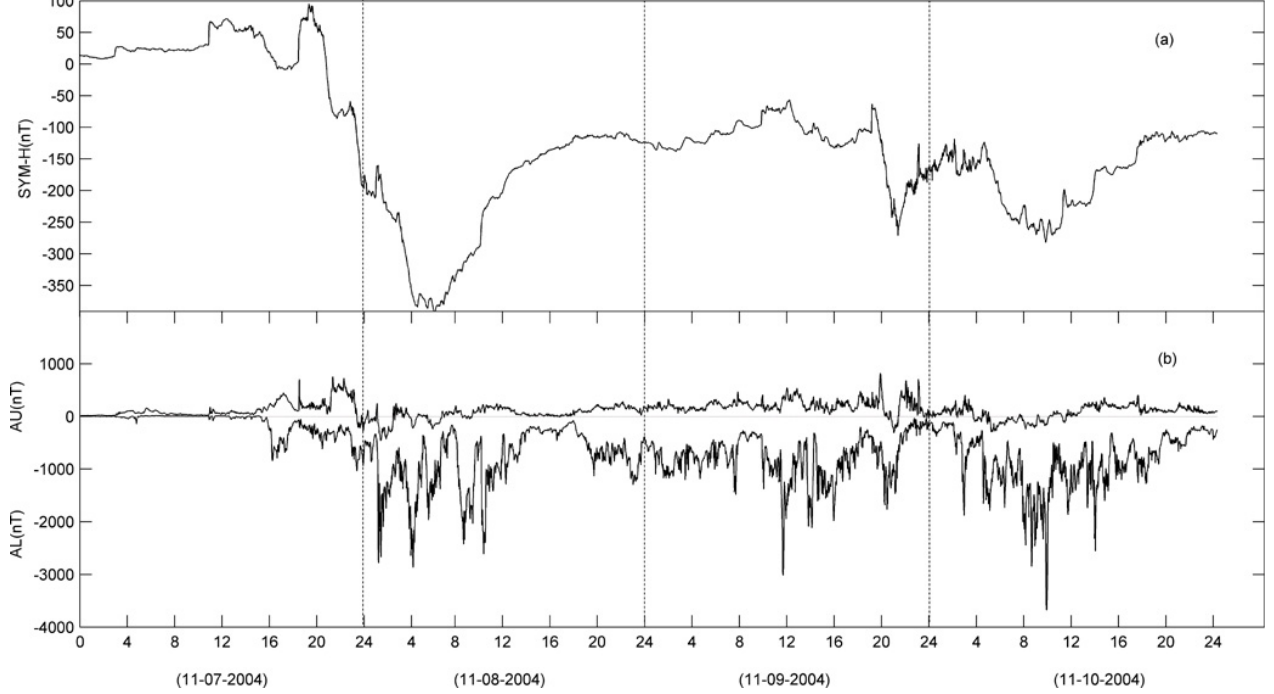
Fig. 2. The variations of the SYM-H (a) , AU and AL (b) indices on 7 ∼ 10 November 2004.